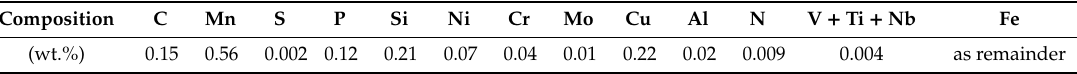
Table 1. Chemical composition of mild steel grade API 5L X42 conveying